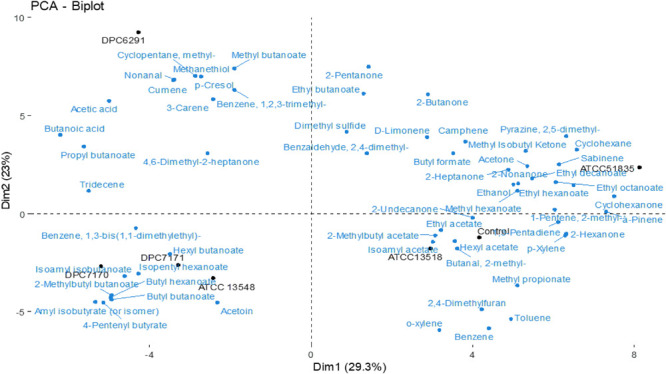
Principle component analysis (PCA) Bioplot illustrates the compounds responsible for the separation between test strains after 24 h incubation in LFM detected via HS-SPME GC-MS. Uninionculated LFM is used as a control.